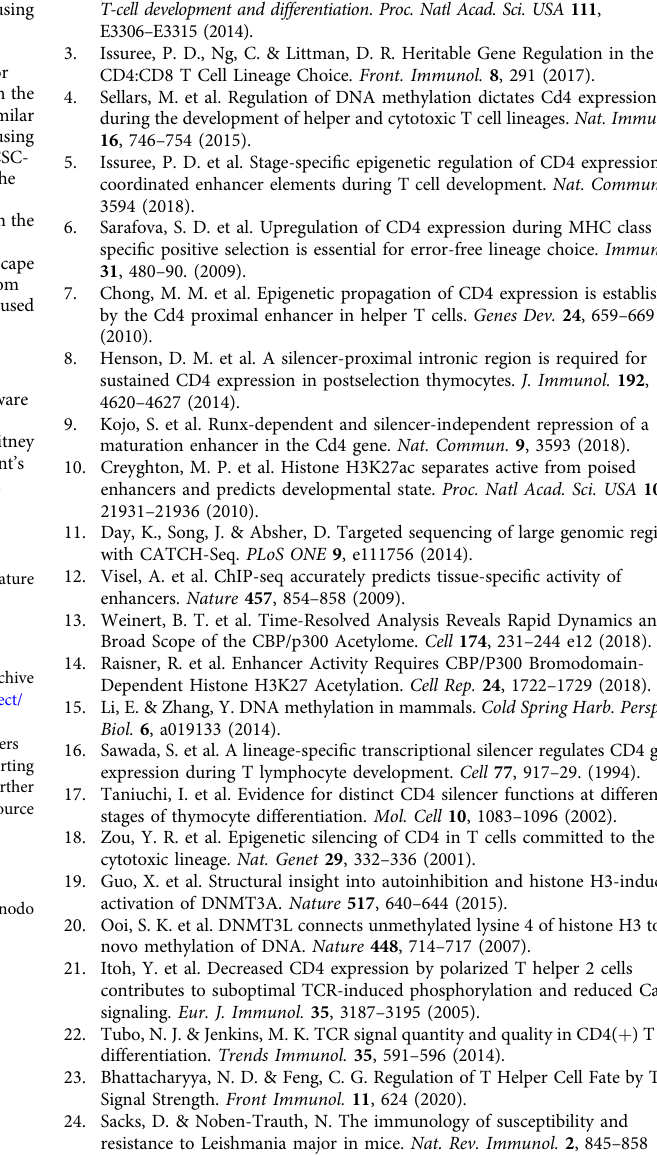
Fig. 7 TET-mediated demethylation during thymic development is critical for optimal gene function in effector T cells. a Venn diagram showing the number of genes that upregulate gene expression (a fold change >2 in gene expression from DN3 to CD4 + SP) intersected with genes that have 5hmC in either DP or CD4 + SP T cells (intragenic 5hmC log2 CMS-IP/input >2) intersected with genes containing open-chromatin ATAC-Seq peaks and H3K27Ac marks in either DP or CD4 + T cells. b Metascape bar graph showing top nonredundant enrichment clusters among genes that have novel-accessibility ATAC-Seq in activated T cells, undergo DNA demethylation, and upregulate RNA expression during thymic development. The number of genes in each cluster is indicated on the left and cluster IDs are shown on the right. Bar graph was generated using the Metascape gene annotation and analysis online resource. p -values were computed using hypergeometric test and Benjamini – Hochberg p -value correction algorithm as previously described in the publicly available Metascape interface 72 . List of genes used for the enrichment analysis is found in Supplementary Table 4. c FACS plot showing CD4, ThPOK, CD5, and CD6 expression in CFSE-labeled T cells from control or Rorc(t) CreTg Tet1 fl / fl Tet2 fl / + Tet3 fl / fl mice 72 hrs post activation. Naive CD4 T cells were FACS- sorted and activated with anti-CD3/CD28. Data is a representative of two experiments with at least two animals/genotype/experiment. d Cd4, Zbtb7b, Cd5 and Cd6 mRNA expression in control or Rorc(t) CreTg Tet1 fl / fl Tet2 fl / + Tet3 fl / fl T cells activated in vitro for 96 hrs with anti-CD3/CD28. Data shown are mean ± SEM ( n = 3). p -values are indicated on graphs (unpaired two-tailed t -test). e IGV snapshots of the Zbtb7b locus depicting p300 and H3K27Ac signals by ChIP-Seq in activated T (Th0) cells and ATAC-Seq peaks in DP, CD4 + thymocytes, and Th0 CD4 + T cells. Red arrows denote currently unde fi ned CREs. Green arrow shows the location of a previously validated CRE PE in CD4 + T cells 61,63 . f IGV snapshot of the Cd5 locus depicting p300 and H3K27Ac signals by ChIP-Seq in activated T (Th0) cells and ATAC Seq peaks in DP, CD4 + thymocytes and Th0 CD4 + T cells. Red arrows denote currently unde fi ned CREs. g IGV snapshot of the Cd6 locus depicting p300 and H3K27Ac signals by ChIP-Seq in activated T (Th0) cells and ATAC-Seq peaks in DP, CD4 + thymocytes and activated CD4 + T cells. Red arrows denote currently unde fi